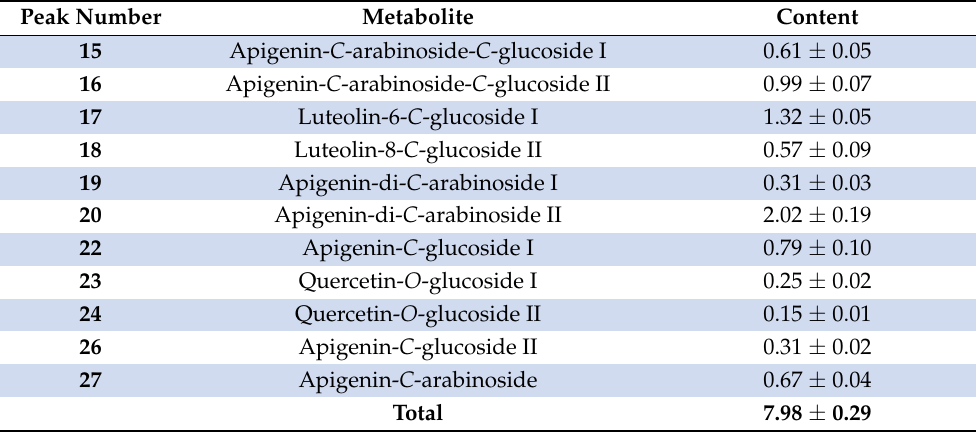
Table 5. Content of flavonoid derivatives (mg/g dry weight) in leaves of S. radiata . The results are presented as mean ± SE of three biological